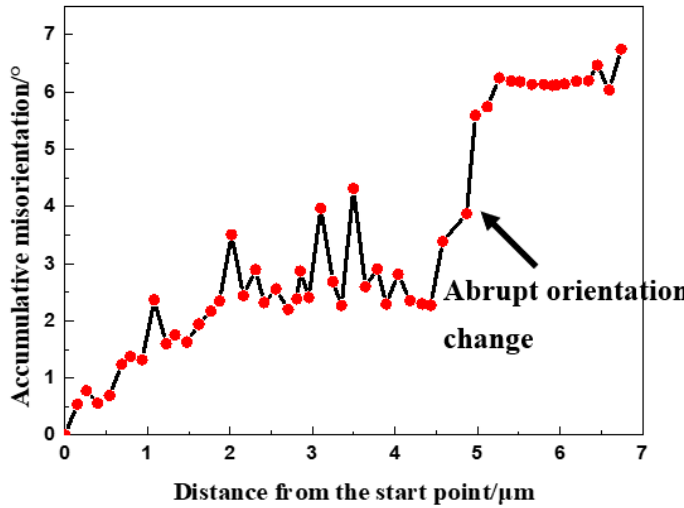
Figure 10. Accumulated misorientation of red line in Figure 9e.